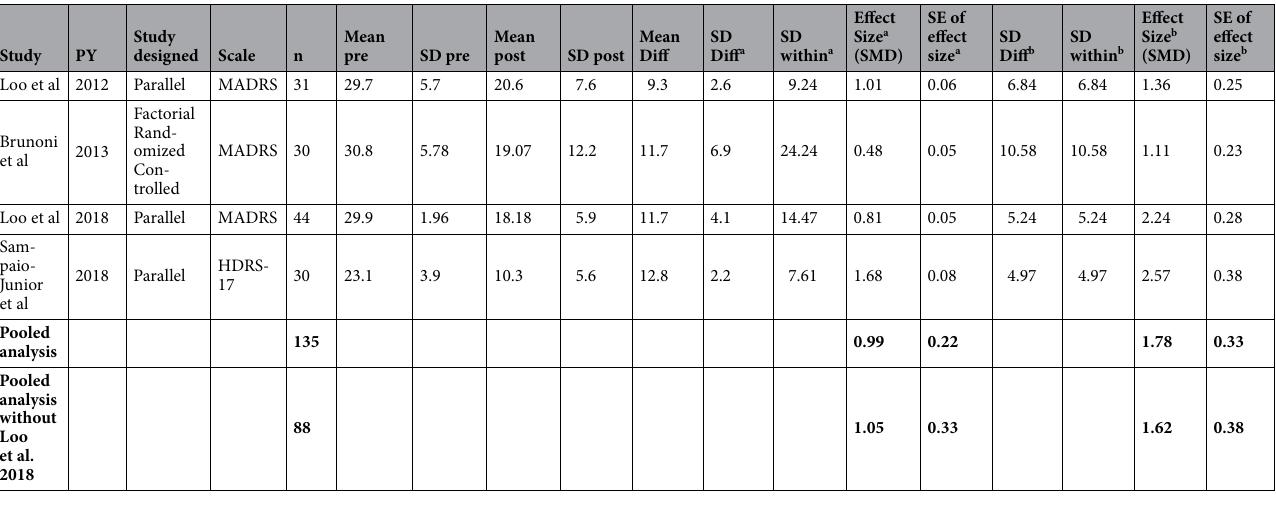
Table 4. Depression. Real. SD = Standard Deviation. SMD = Standardized Mean Difference. SE = Standard Error. Note: a Correlation pre-post r = 0.96. b Correlation pre-post r =